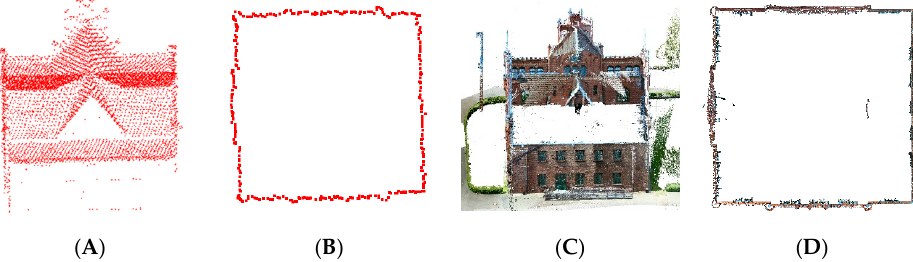
Figure 5. Results of 2D façade point extraction and 2D boundary point extraction. ( A ) The open LiDAR data. ( B ) The boundary points (top view) extracted from open LiDAR data. ( C ) The façade point cloud. ( D ) The façade boundary points (top view) extracted from the façade point cloud.